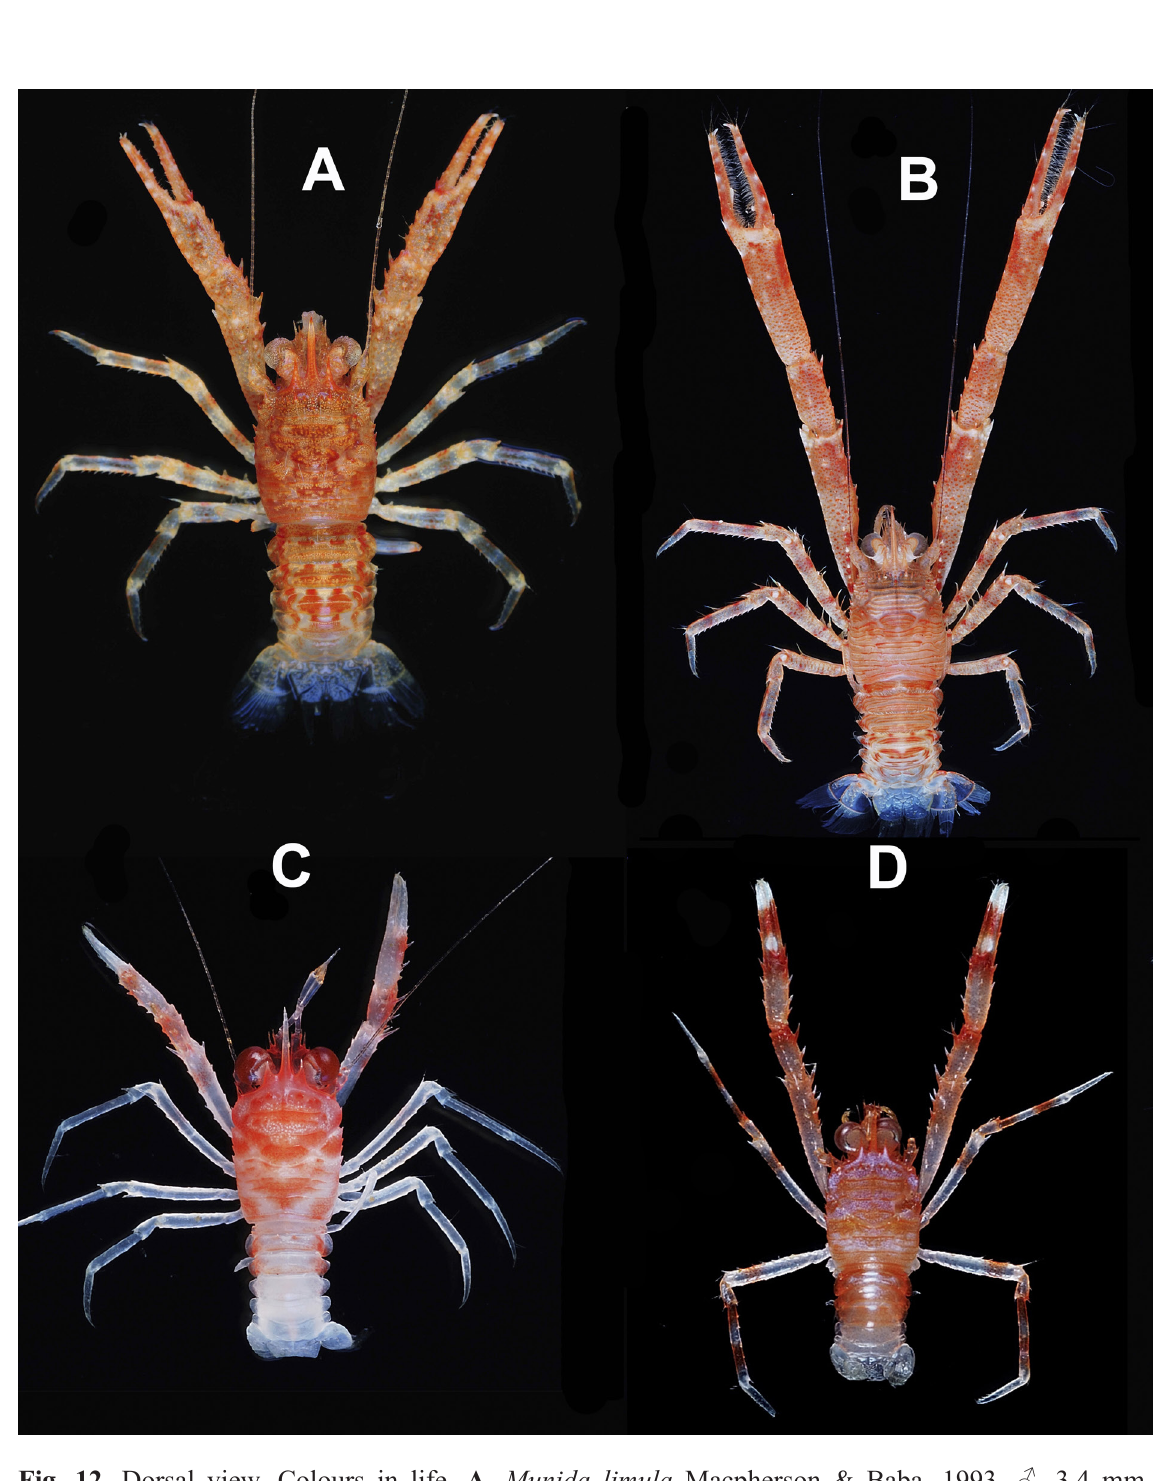
Fig. 12. Dorsal view. Colours in life. A . Munida limula Macpherson & Baba, 1993, ♂, 3.4 mm, Madagascar, ATIMO VATAE, Stn TP12. B . Munida mesembria sp. nov., paratype, ♀, 6.5 mm, Mozambique, MAINBAZA, Stn CP3130. C . Munida micra sp. nov., holotype, ♂, 3.7 mm, Mozambique, MAINBAZA, Stn CC3165. D . Munida muscae Macpherson & de Saint Laurent, 2002, ♂, 3.2 mm, Madagascar, MIRIKY, Stn